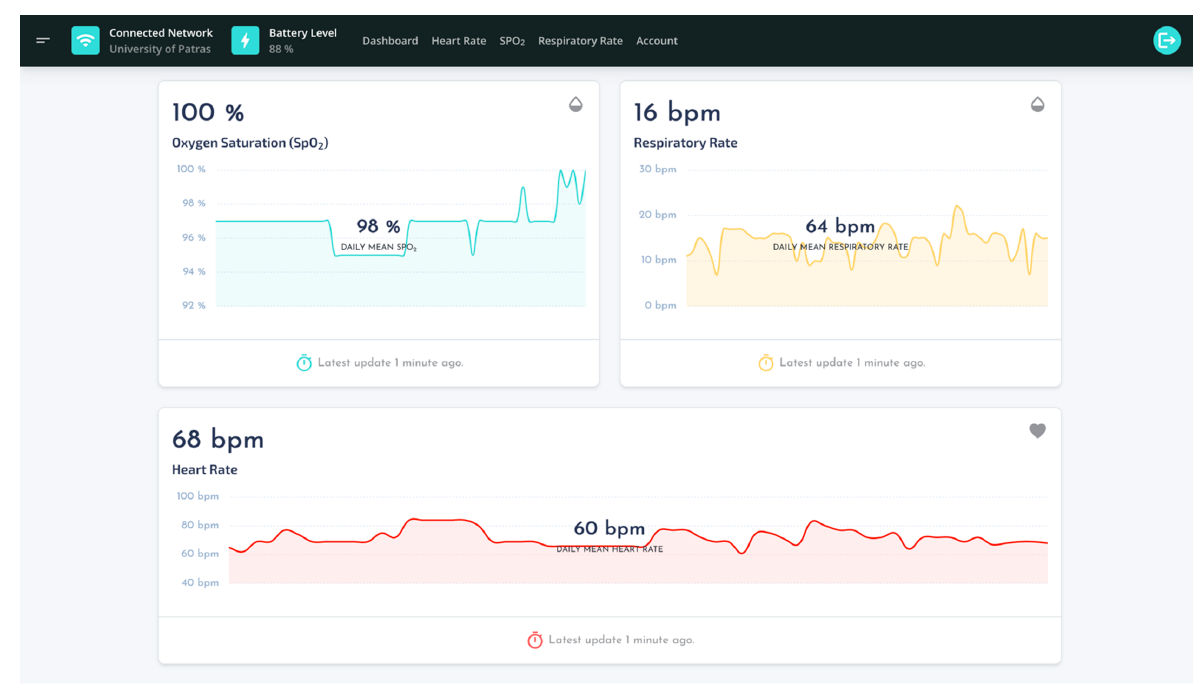
Figure 11. The UI of dashboard.